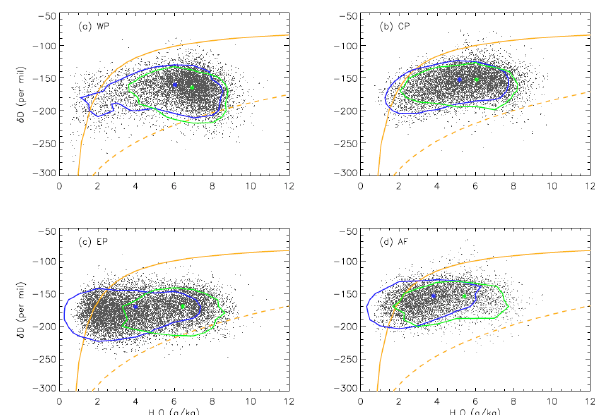
Fig. 5. Bivariate plots of water vapor versus its isotope during JJA over tropical ocean (charcoal dots). Each solid line represents 95% of a probability density function for clear sky (blue) and nonprecipitating clouds (green). The symbols ‘*’ represent mean values of water vapor and its isotope. Solid evaporation line depicts turbulent mixing of water vapor from the saturated layer at the ocean surface into a drier air parcel aloft. A Rayleigh distillation model (dotted) describes isotopic depletion as vapor is lost to precipita- tion. (a) Western Pacific (5 ◦ − 15 ◦ N, 120 ◦ –160 ◦ E), (b) Central pa- cific (5 ◦ − 15 ◦ N, 160 ◦ E–160 ◦ W), (c) Eastern Pacific (5 ◦ − 15 ◦ N, 150 ◦ − 100 ◦ W) and (d) Africa (5 ◦ –15 ◦ N, 50 ◦ E–25 ◦ W). Table 2. The mean of TES measured water vapor and HDO/H 2 O ratio (850–500hPa) from clear sky and nonprecipitating clouds in the three regions, WP, CP and EP. Clear sky and nonprecipitating clouds values are separated by commas. WP (clear sky, nonprecipitating clouds) 6.0, 6.8 − 165.9, − 170.1 CP (clear sky, nonprecipitating clouds) 5.0, 6.0 EP (clear sky, nonprecipitating clouds) 3.8, 6.3 − 175.9, − 175.0